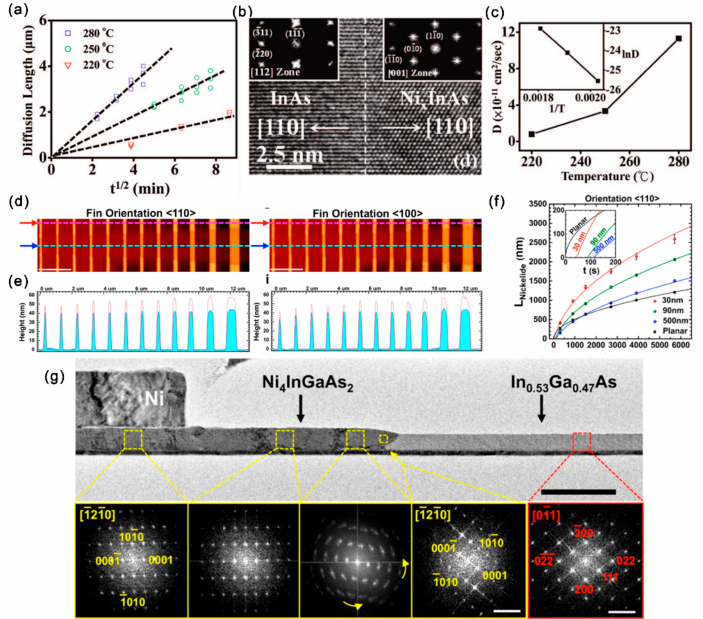
Figure 8. ( a ) Ni diffusion length vs. t 1/2 at diffusion temperatures of 220, 250 and 280 ◦ C ( b ) HRTEM image showing the InAs/Ni x InAs interface. ( c ) The diffusivity of Ni in InAs as a function of tem- perature. Reproduced with permission [88]. Copyright 2008, American Chemical Society. ( d ) AFM topography plots of the nickelide-InGaAs Fin channels. Scale bars are 2 µ m. ( e ) The height profiles for nickelide segments and nonreacted InGaAs segments correspond to the line cuts in ( d ). ( f ) The length of nickelide segments vs. annealing time at 250 ◦ C for <110> Fin orientations. ( g ) TEM image of the [110]-oriented Fin with nickelide formation. Reproduced with permission [91]. Copyright 2015, American Chemical